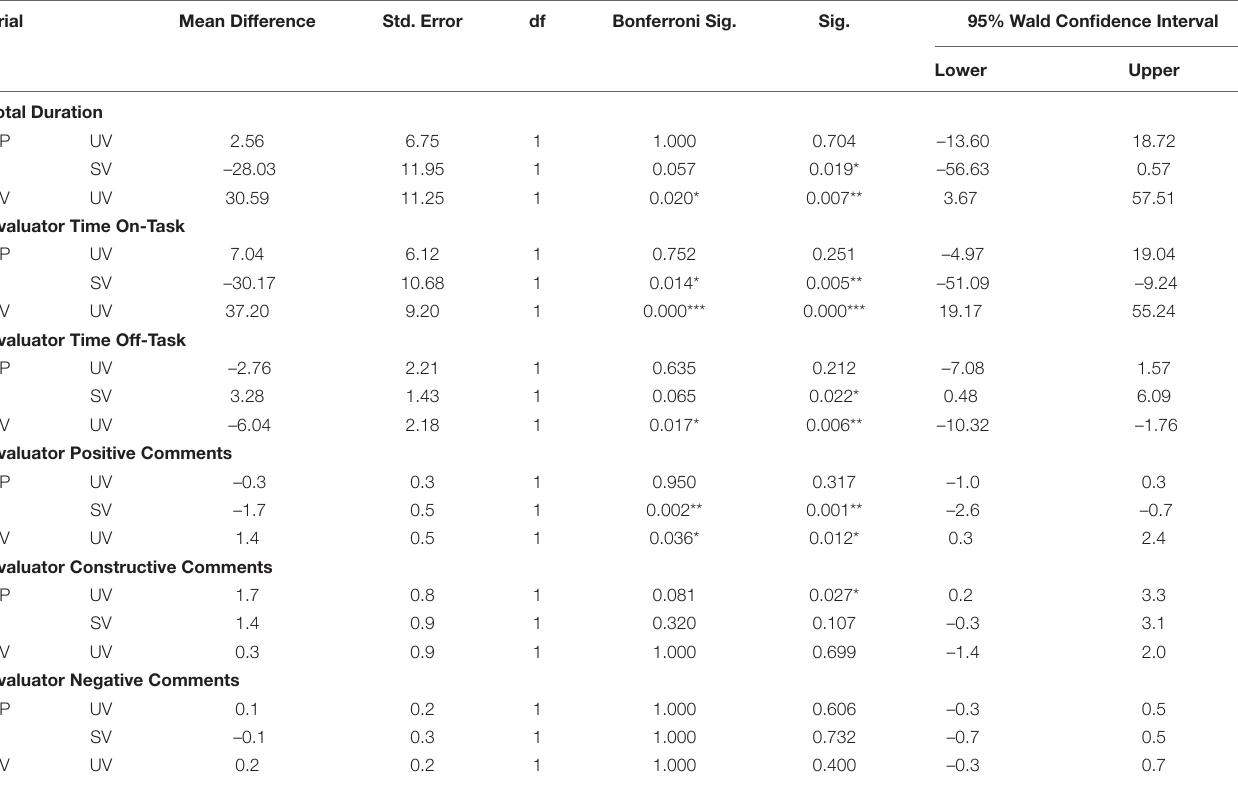
TABLE 4 | Between group pairwise comparison of evaluator duration, on-task, off-task variables, and evaluator comments. Trial Mean